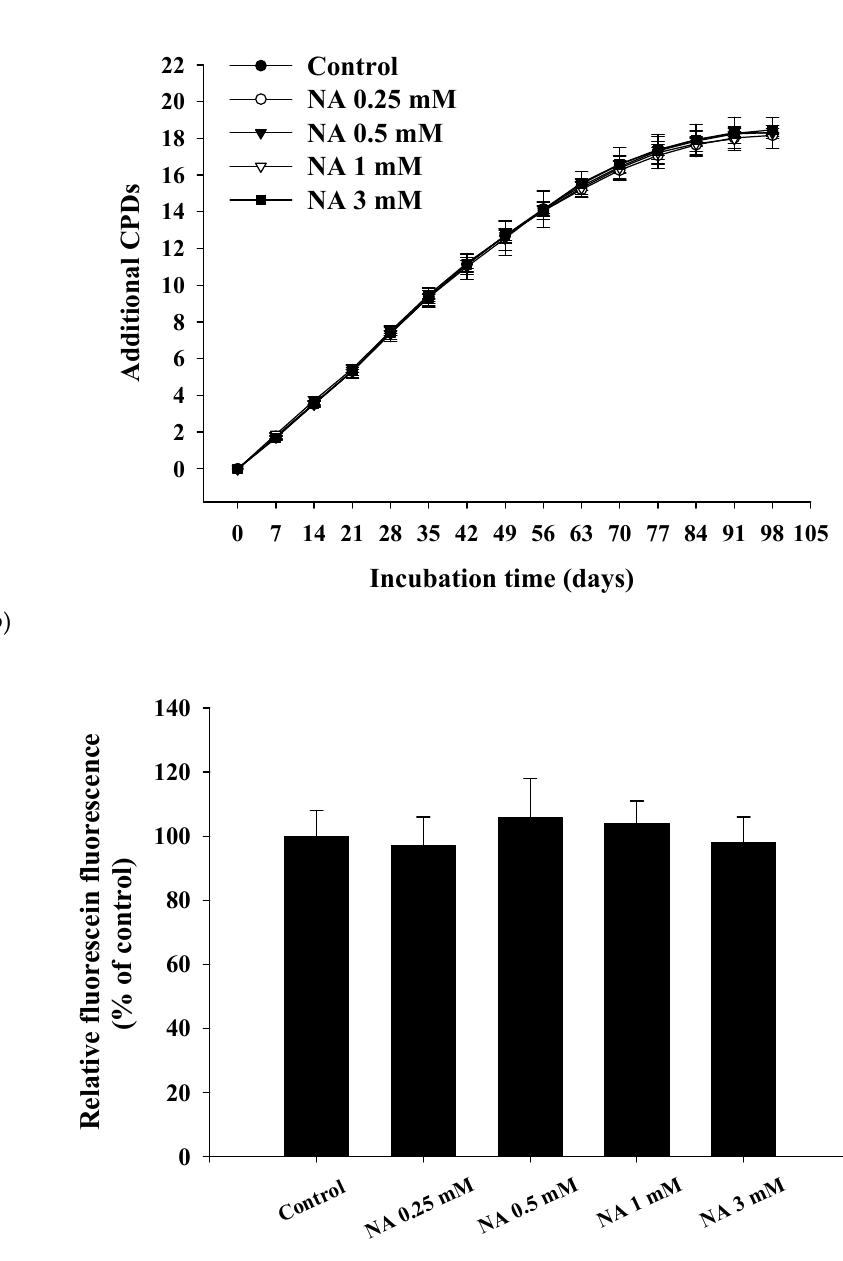
Figure 2. E ff ects of nicotinic acid (NA) on the replicative lifespan and senescence-associated β -galactosidase (SA- β G) activity. Hs68 cells were serially cultured in medium containing 0, 0.25, 0.5, 1, and 3 mM NA. ( a ) Cumulative growth curves were obtained to determine the replicative lifespan. ( b ) On day 91 of the serial culture, SA- β G activities were measured by the double-substrate method, and the fluorescein fluorescence is shown as a % of the control. Values are mean ± SD, n = 3 plates.